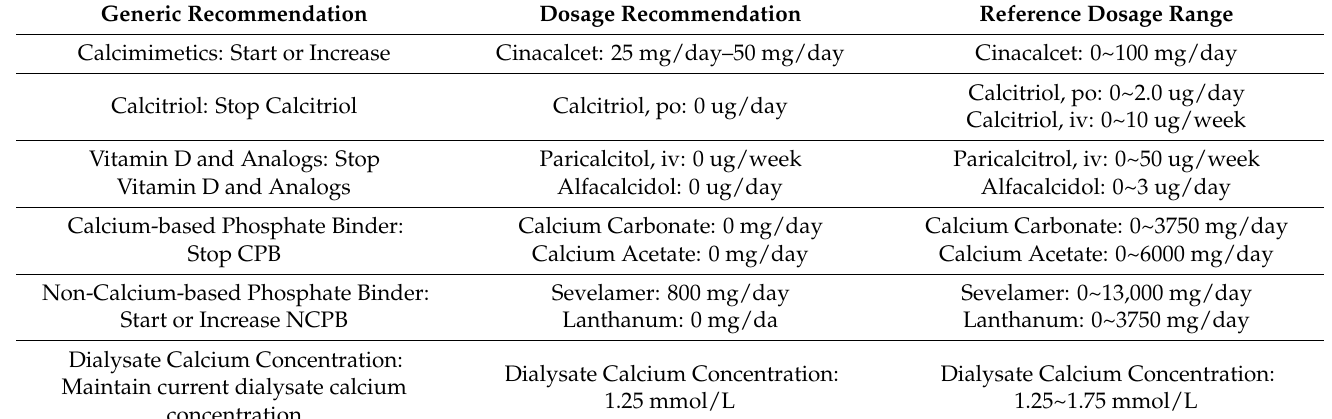
Table 7. A sample medication dosage recommendation with respect to generic recommendation.